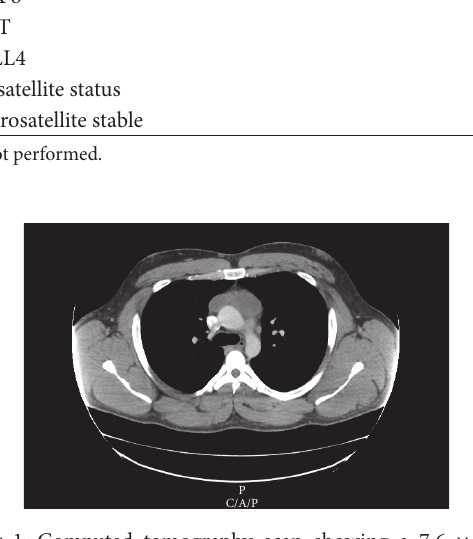
Figure 1: Computed tomography scan showing a 7.6 × 2.6 cm anterior mediastinal mass.